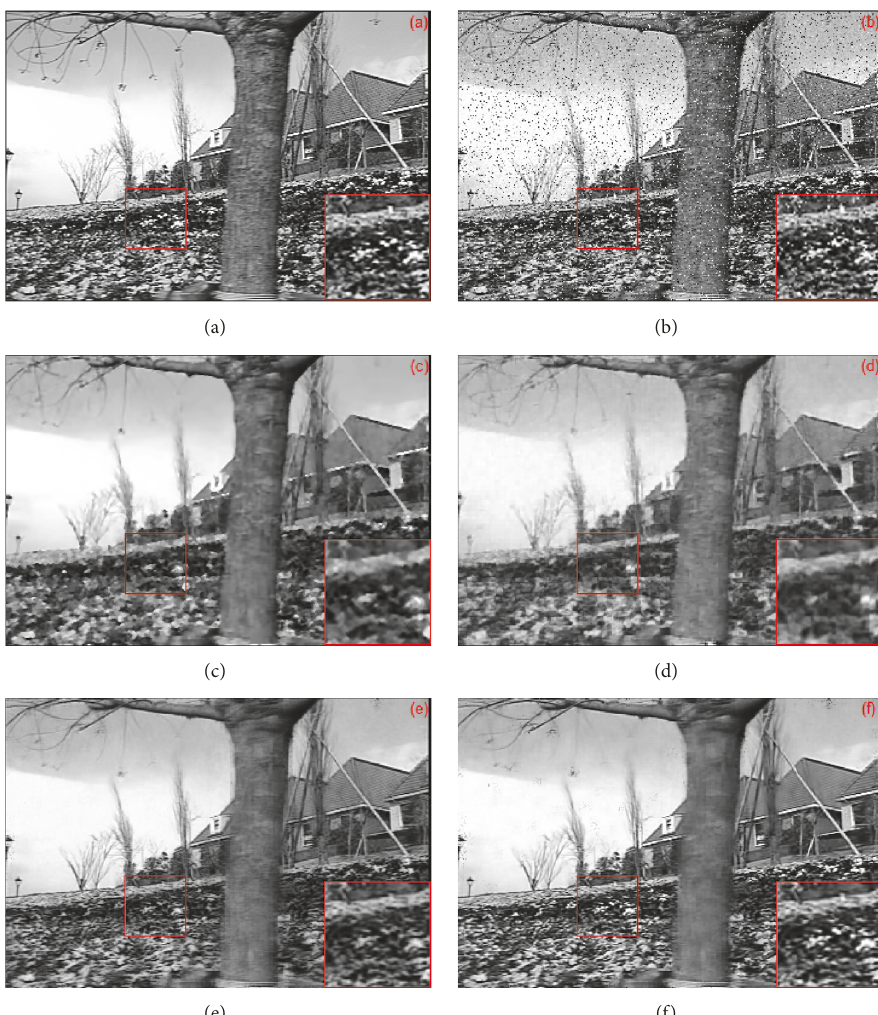
Figure 2: Visual comparison of denoising results on flower by noise level (𝜎, si ) = (10,10 % ) . (a) Original sample (flower) , (b) noisy image, (c) VBM3D based method (PSNR = 19.62 ), (d) RPCA based method (PSNR = 22.11 ), (e) ℓ 1 - ℓ 0 based method (PSNR = 19.45 ), and (f) the proposed method (PSNR = 23.01 , 𝑘 = 2000